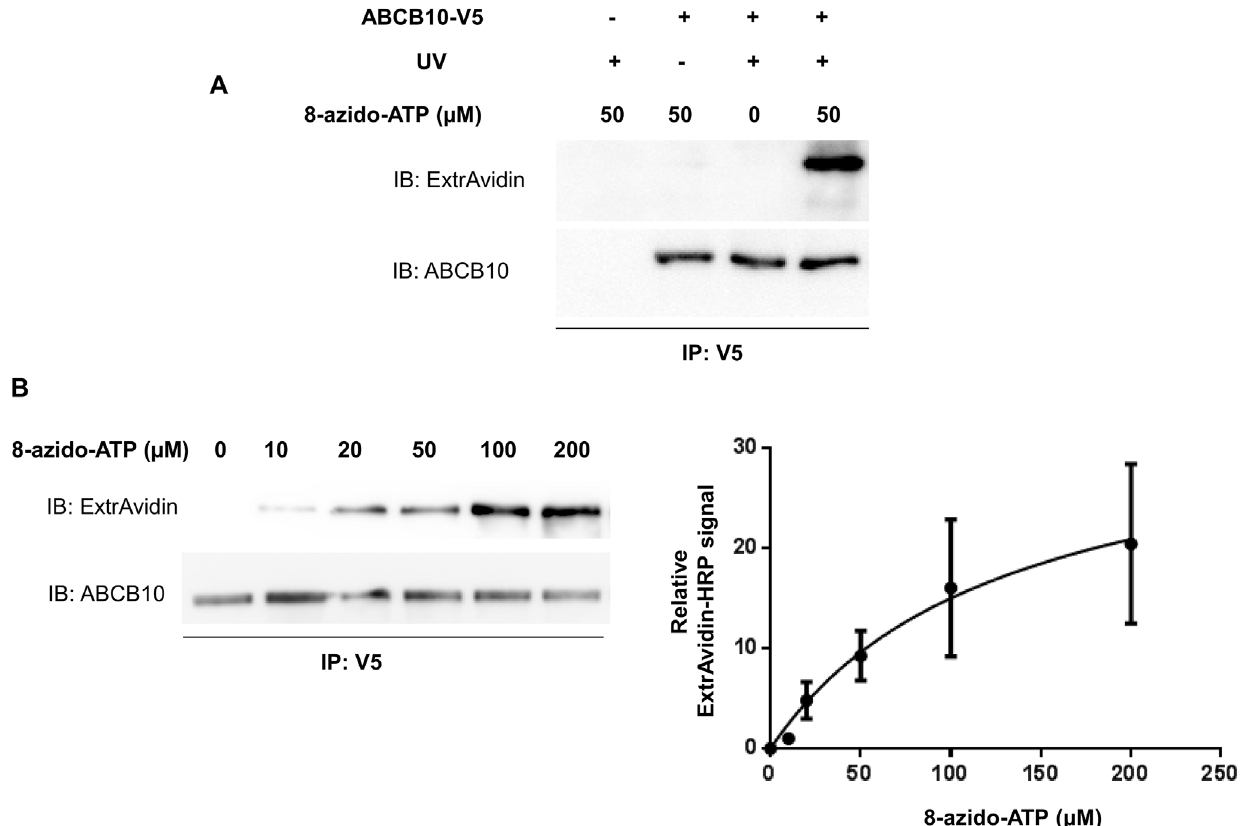
Fig 2. Photolabeling and ATP binding characteristics of ABCB10 using 8-azido-ATP [ γ ] biotin. A) SMPs (80 μ g protein) from Control (-) or ABCB10-V5 (+) transfected cells were incubated with 0 or 50 μ M of 8-azido-ATP [ γ ] biotin on ice for 5 min, treated with (+) or without (-) UV light for another 5 min and followed by IP with anti-V5 agarose affinity gel beads. After SDS-PAGE of the IP, membranes were blotted with ExtrAvidin-HRP (1:1000) or anti-ABCB10 antibody (1:2000). B) Representative Western blot shows that 8-azido-ATP [ γ ] biotin binding to ABCB10 was dose-dependent. Michaelis-Menten curve obtained from Western blot analyses is shown, with a Km value of 128.3 μ M. Three independent experiments were conducted and data are shown as mean ± SEM.